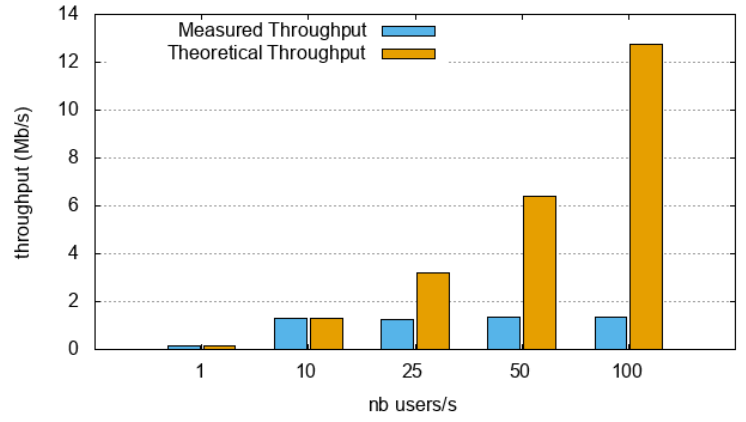
Figure 11. Throughput evaluation under stress/load test on node2 (Parking Energy O-MI node).